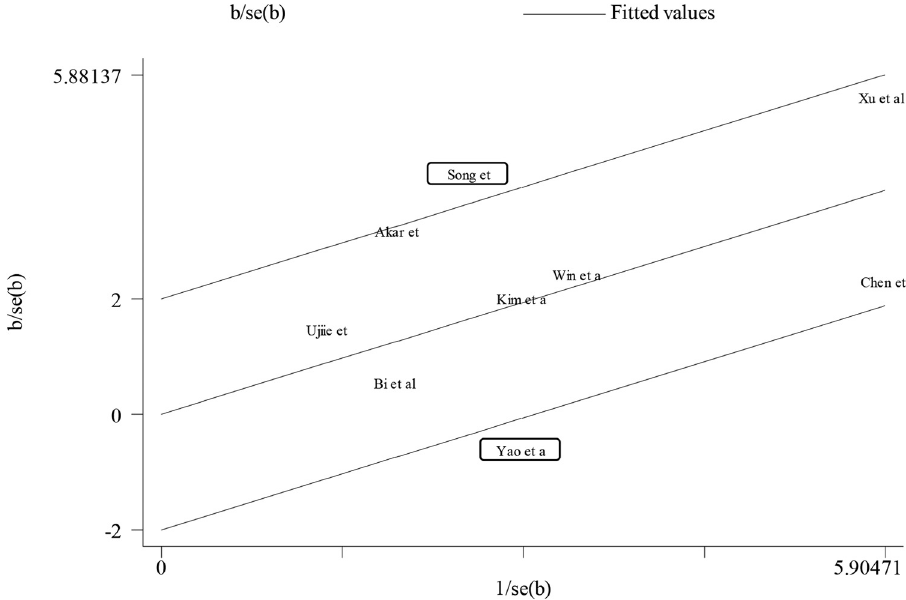
Figure 3: Galbraith plot for the association between NNMT expression and OS showing that studies of Song et al. and Yao et al. were the main sources of heterogeneity based on the Galbraith